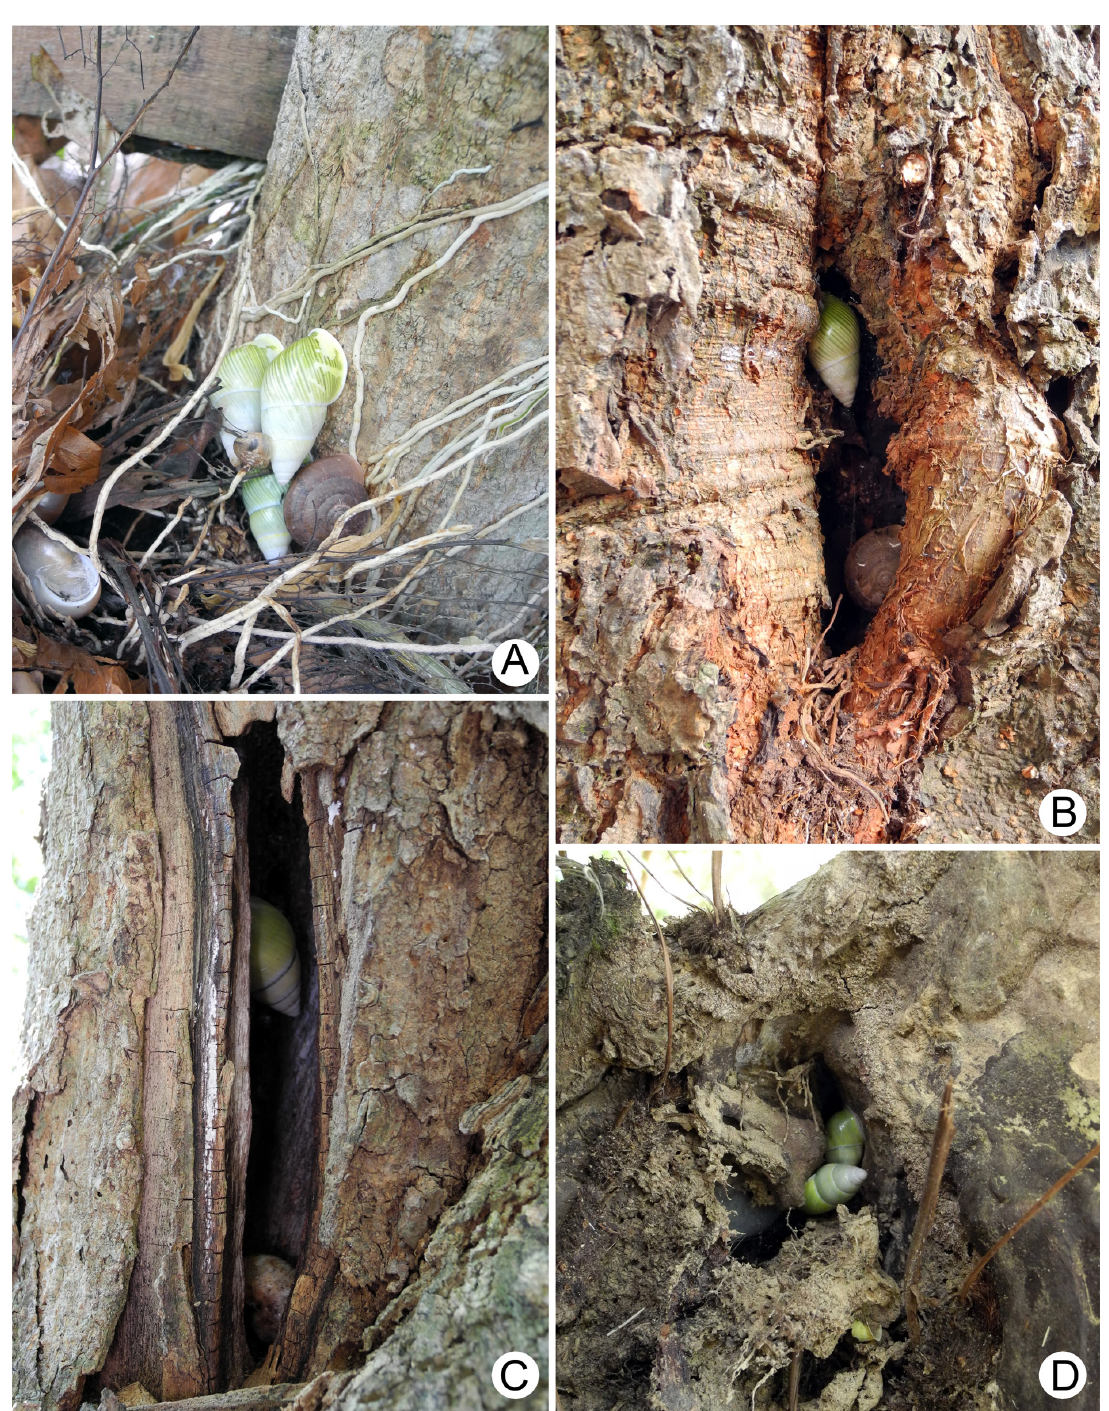
Fig. 3. Aestivation sites of Amphidromus species. A–B . Amphidromus roseolabiatus Fulton, 1896 (shell height about 34 mm) from NamTurn Bridge, Bolikhamxay, Laos, aestivated. A . Inside sterile fronds of stag horn ferns, Platycerium Desv. B . In a small hole on a Jackfruit tree trunk, Artocarpus heterophyllus Lam., with other snails, Quantula Baker, 1941 and Durgella Blanford, 1863. C . Amphidromus givenchyi Geret, 1912 (shell height about 43 mm), hiding in a small hole of a dipterocarpus tree shell. D . Amphidromus syndromoideus sp. nov. (shell height about 28 mm) from the type locality, hiding in a hole of a tree, visible after removal of clusters of sterile fronds of the basket fern Drynaria (Bory) J.